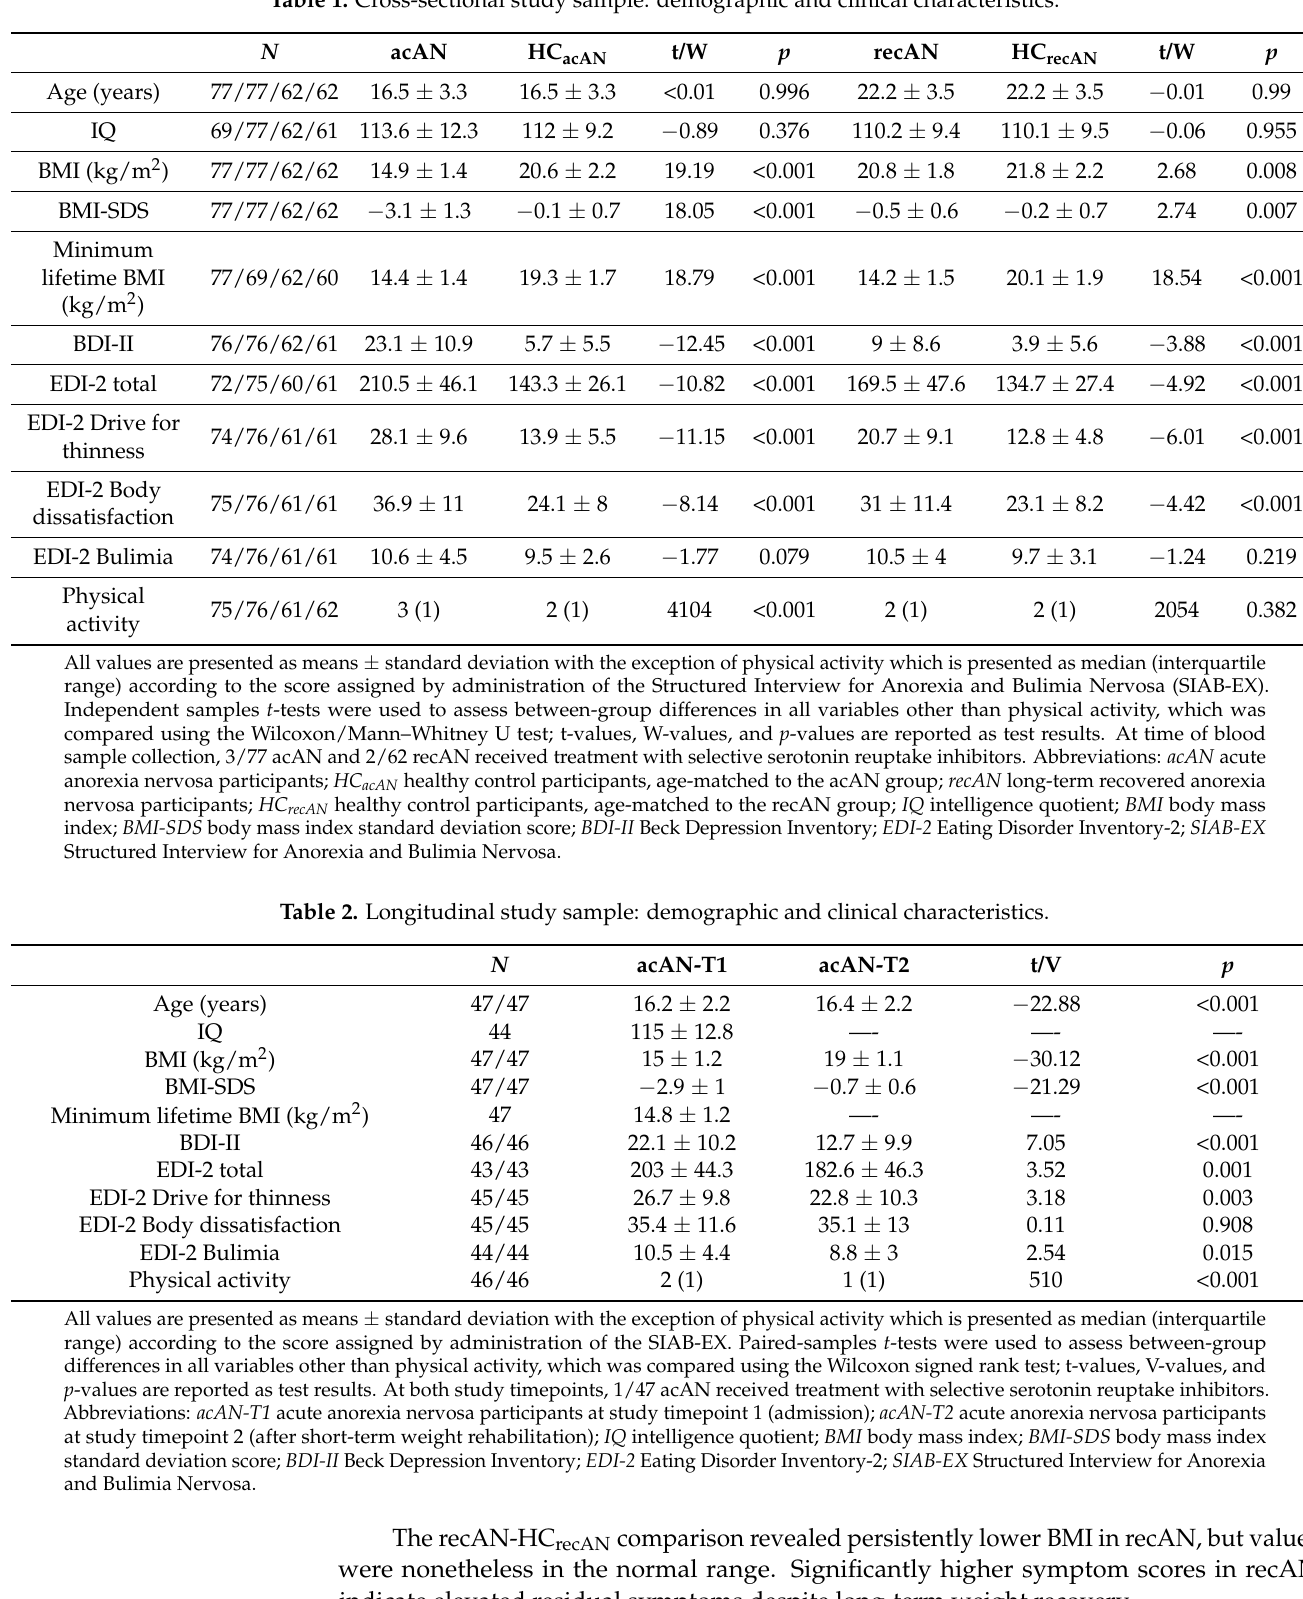
Table 1. Cross-sectional study sample: demographic and clinical characteristics.